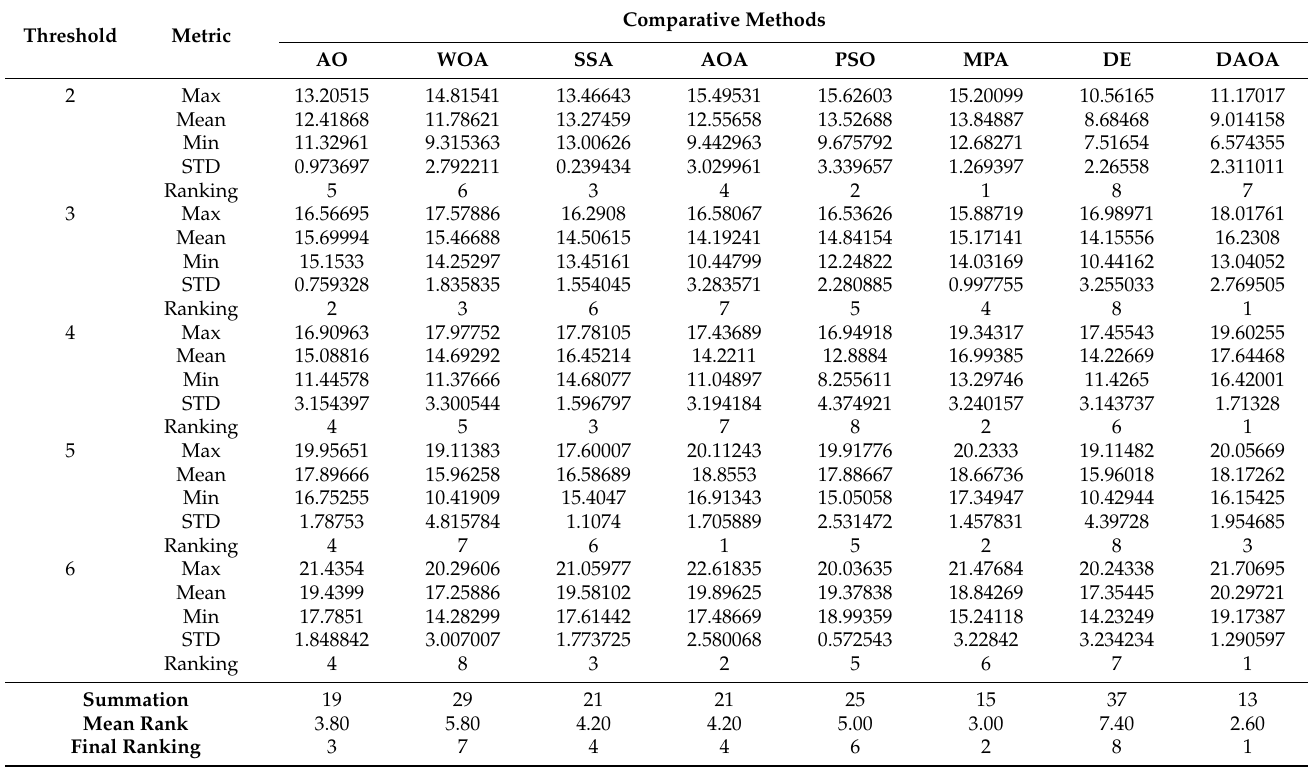
Table 14. The PSNR results of the test case 7.